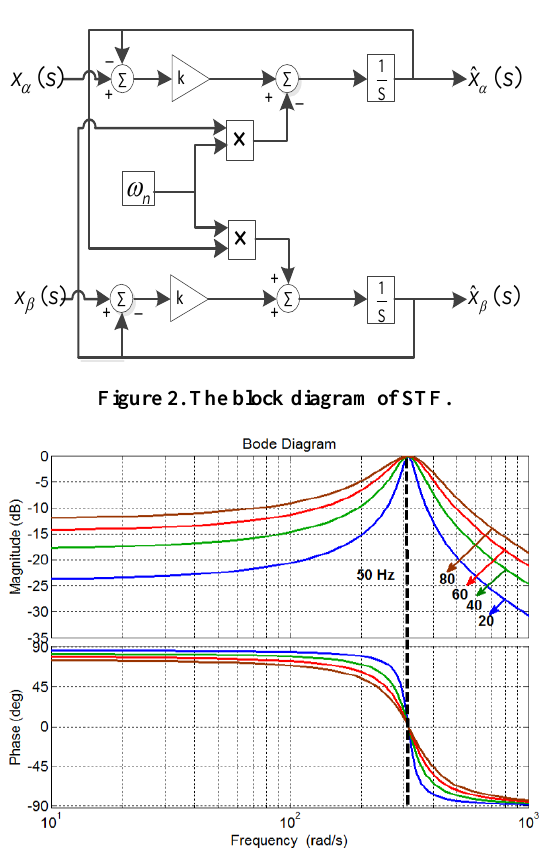
Figure 3. Bode diagram for the STF versus pulsation for different values of the parameter k